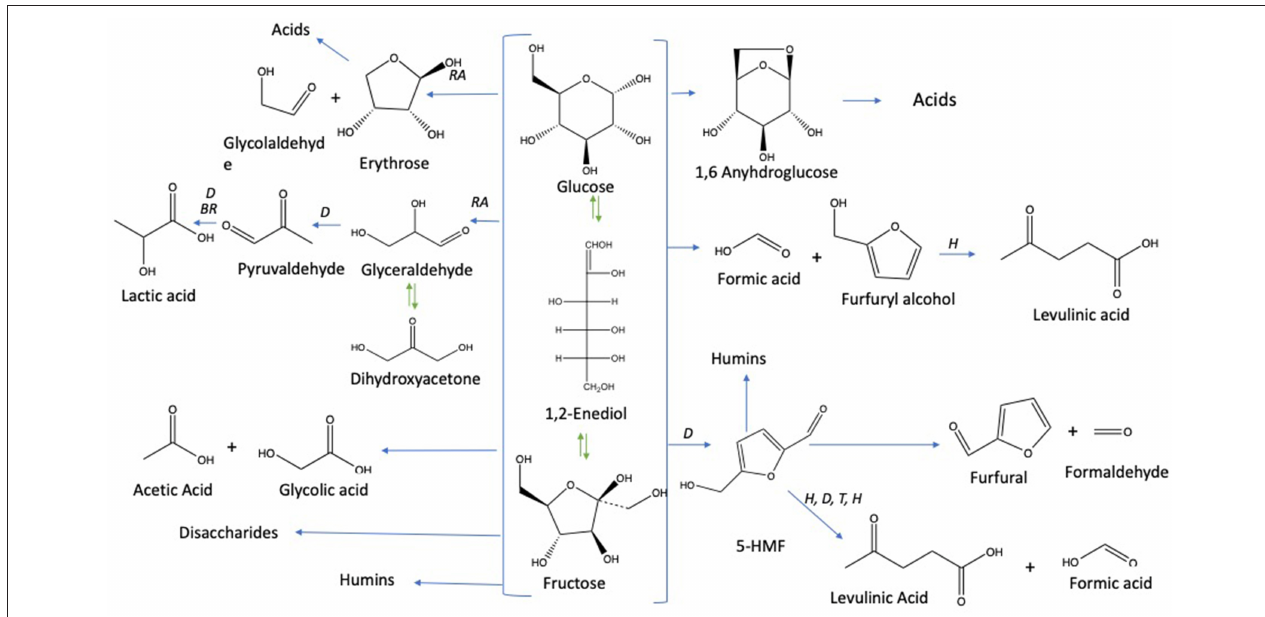
FIGURE 2 | D-glucose conversion pathways in subcritical water adapted from the works of Kabyemela et al. (1999); Watanabe et al. (2005); Rasrendra et al. (2010); Assary et al. (2012) , and Aida et al. (2007). Reactions: D, dehydration; P, polymerization; BR, benzilic acid rearrangement; I, isomerization by Lobry de Bruyn–van Ekenstein transformation, RA: retro -aldol, H: